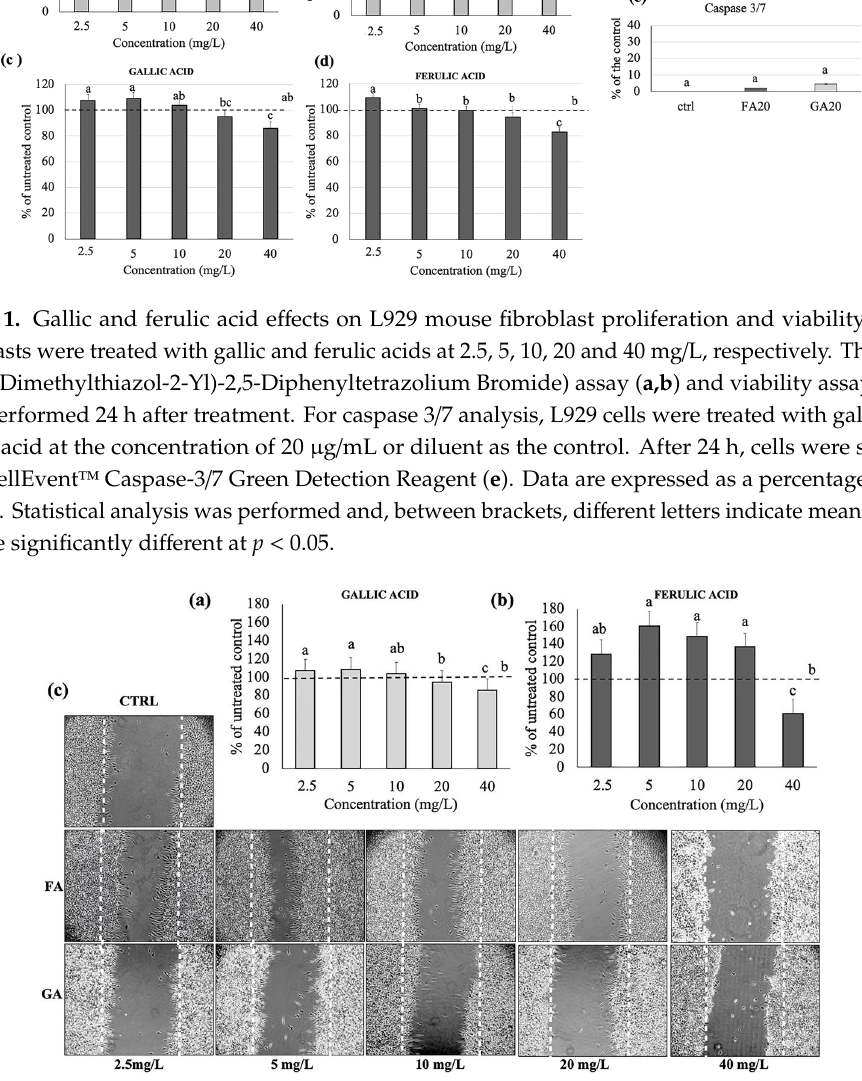
Figure 2. Wound-healing assay using L929 with gallic and ferulic acid. ( a ) number of fibroblasts migrated after treatment with gallic and ( b ) ferulic acids at 2.5, 5, 10, 20 and 40 mg/L. ( c ) Significant pictures of the migrated cells. Data were expressed as percentage compared to the control. Statistical analysis was performed, and between brackets, different letters indicate mean values that are significantly different at p < 0.05.